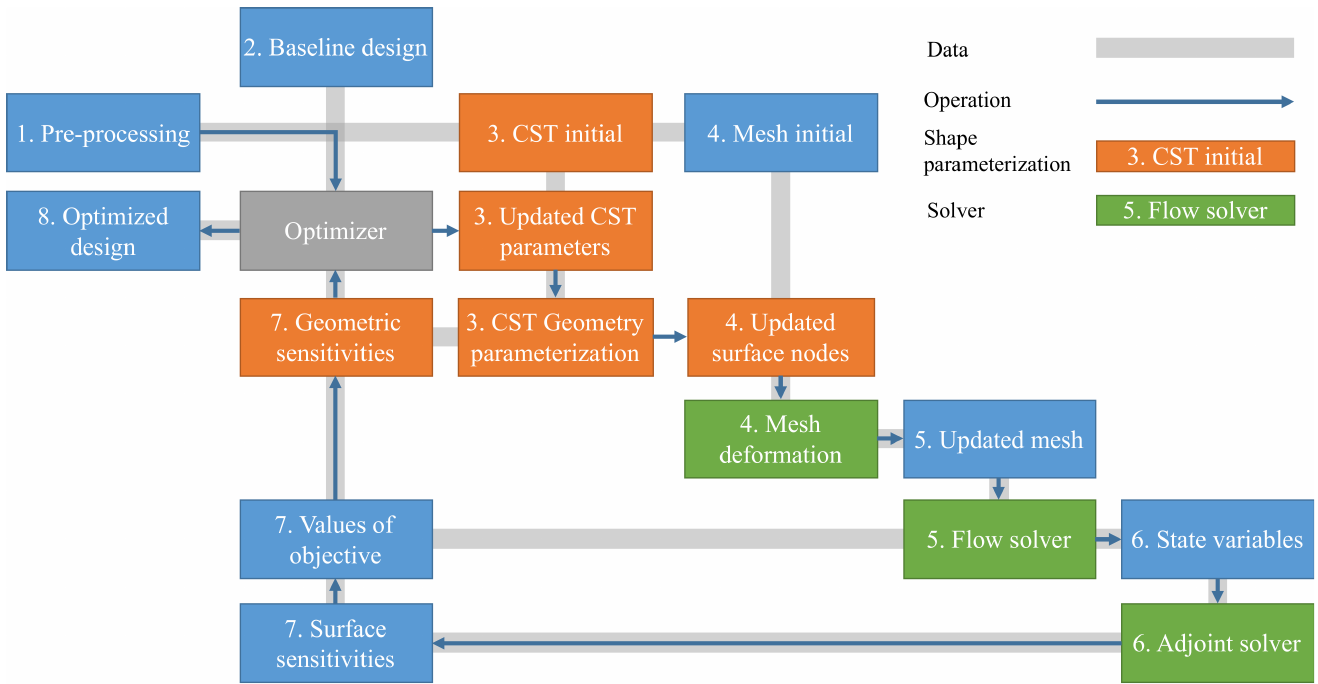
Figure 1. Optimization